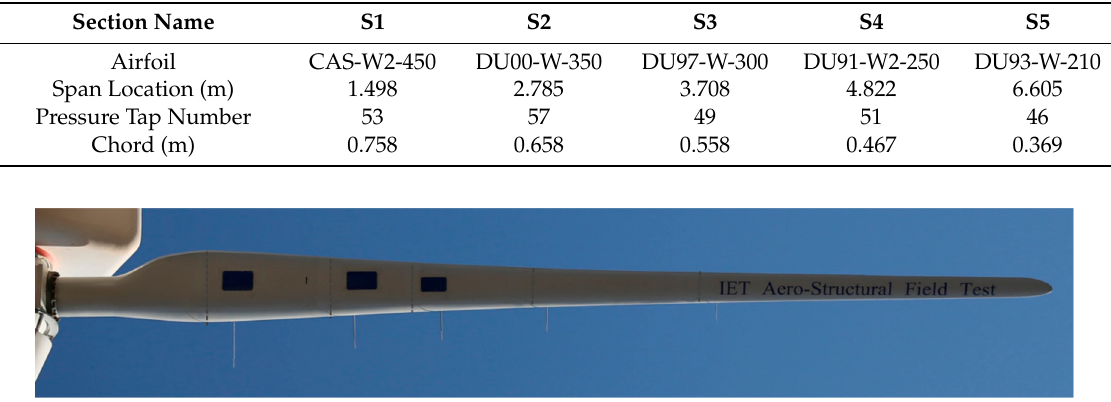
Table 6. Parameters of five pressure measurement sections.